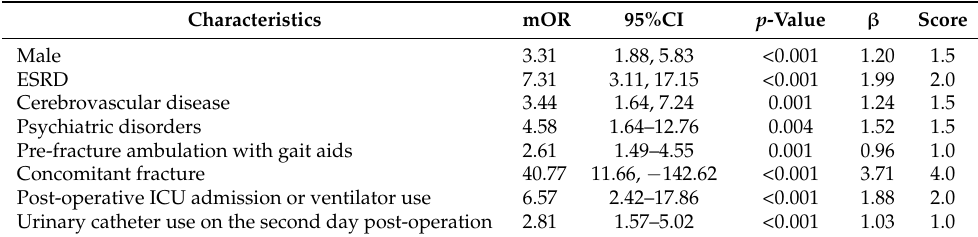
Table 3. Best multivariable clinical predictors for assigned item